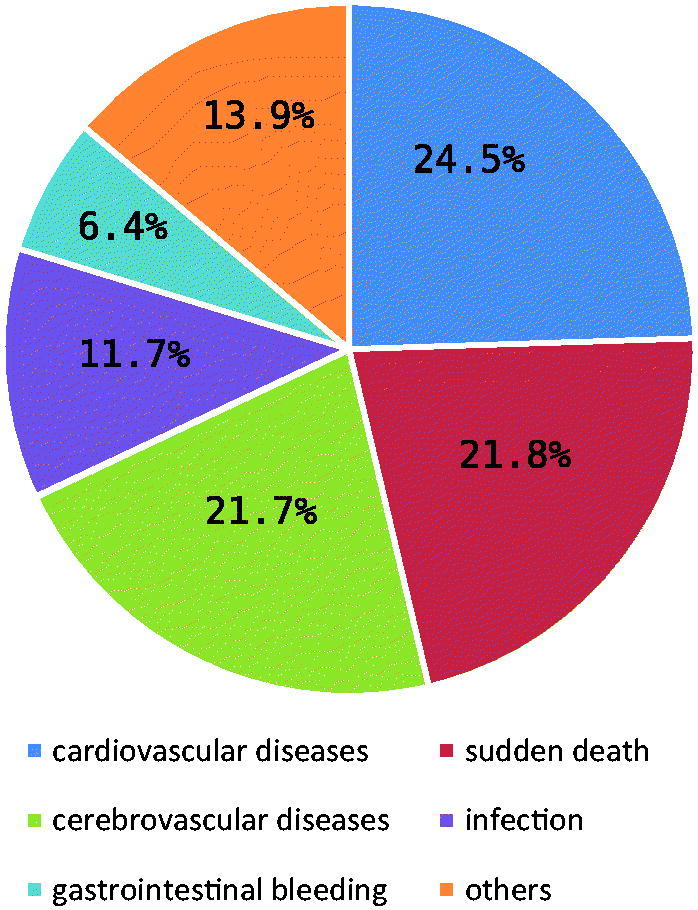
The constitution of causes of death for ESRD-HD patients from 2011 to 2016 (%).